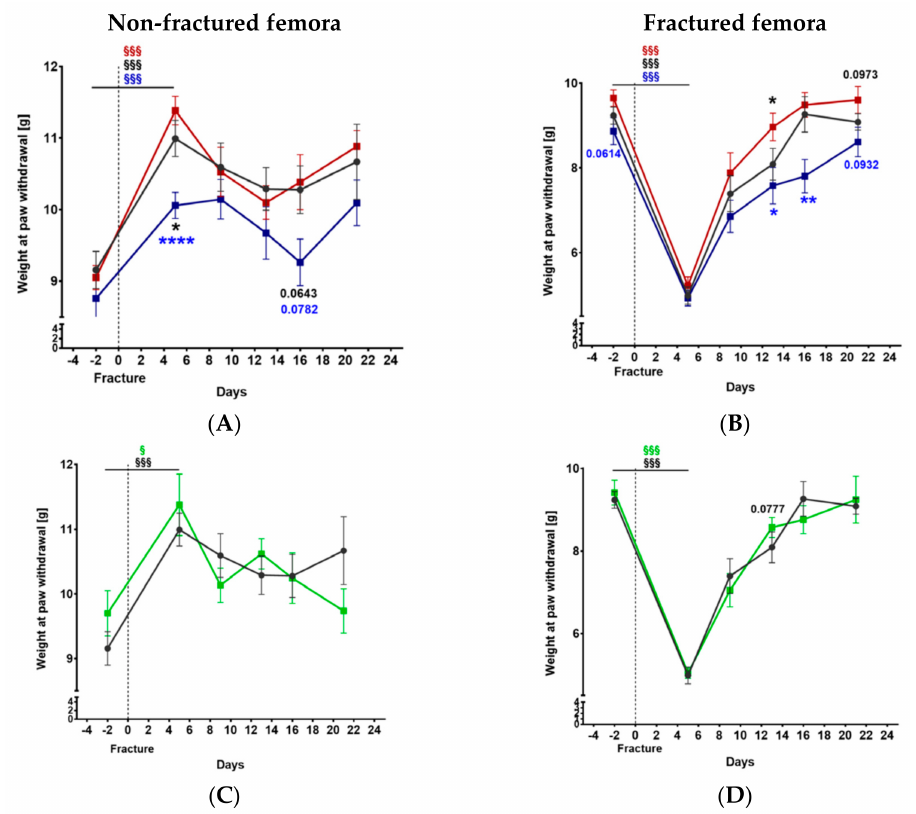
Figure 2. The time course of mechanical hyperalgesia before and after fracture. The withdrawal threshold was measured using the Dynamic Plantar Aesthesiometer test for the non-fractured ( A , B ) and the fractured ( C , D ) femora of Tac1 − / − , α -CGRP − / − ( A , C ), and SYX ( B , D ) mice in comparison to WT (black) mice. Data are expressed as mean ± SEM. § / §§§ indicates significance within the respective groups, demonstrated by the respective color. * / p -values in black indicate di ff erences between neurotransmitter deficient mice and WT animals. * / ** / **** / p -Values in blue indicate di ff erences between Tac1 − / − and α -CGRP − / − mice. * = p ≤ 0.05; ** = p ≤ 0.01; **** = p ≤ 0.0001. N =